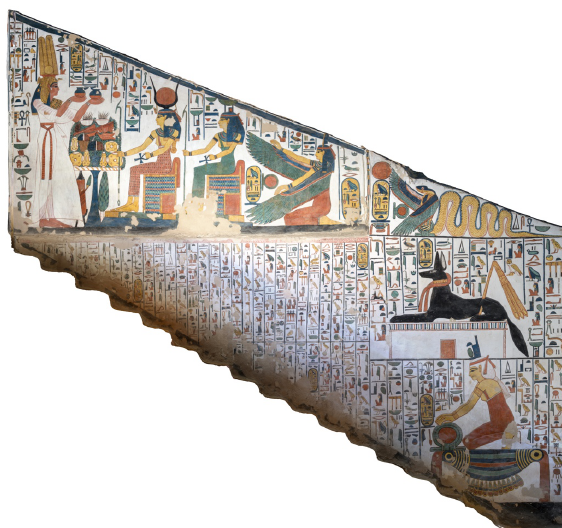
Figure 4. The lower half of the stairway wall paintings in this orthophoto are in shadow due to the position of a handrail in the Tomb of Nefertari (Credit: Carleton Immersive Media Studio; Carleton University. © J. Paul Getty Trust).